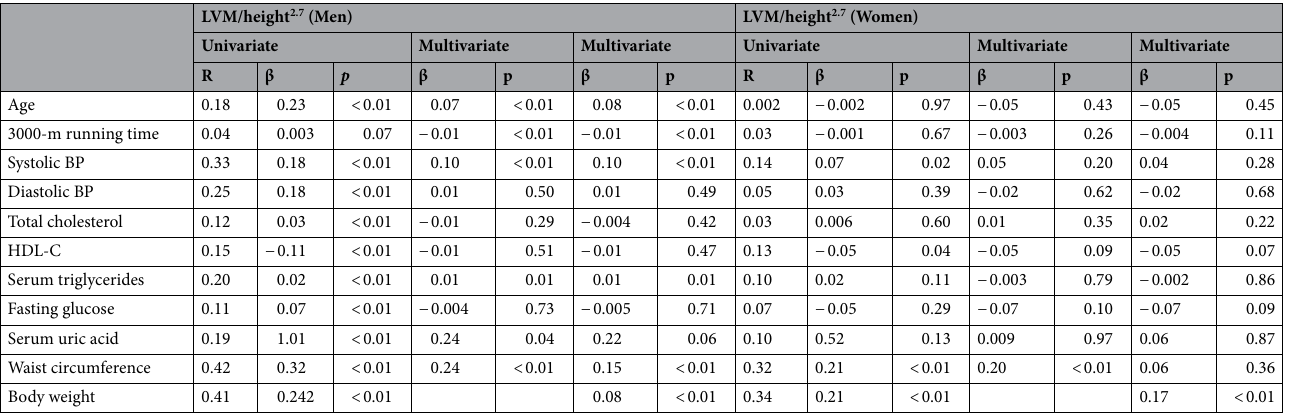
Table 2. Sex-Specific Correlations between Cardiometabolic Risk Factors and LVMI. Multiple linear regression analysis was used to determine the association of LVM index with age, 3000-m running time,